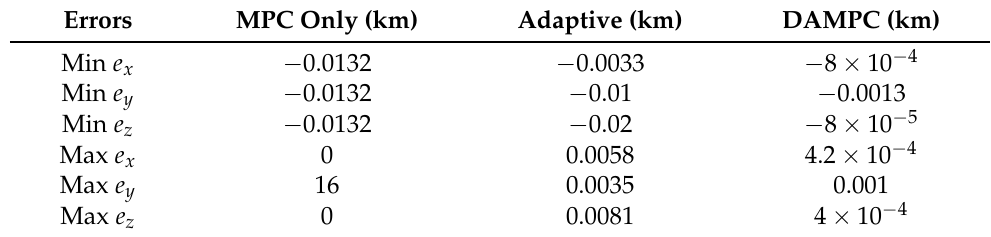
Table 4. Output errors for asteroid Kleopatra.